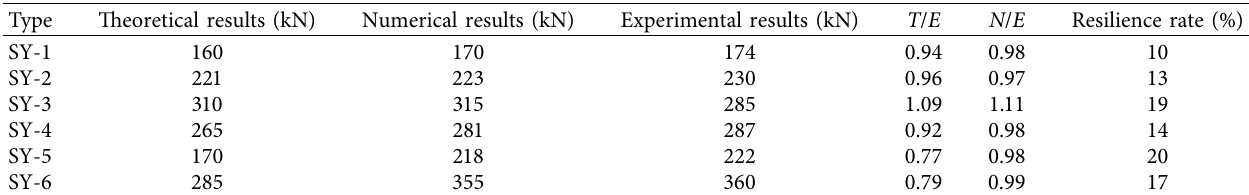
Table 4: Comparison of bearing capacity of screw